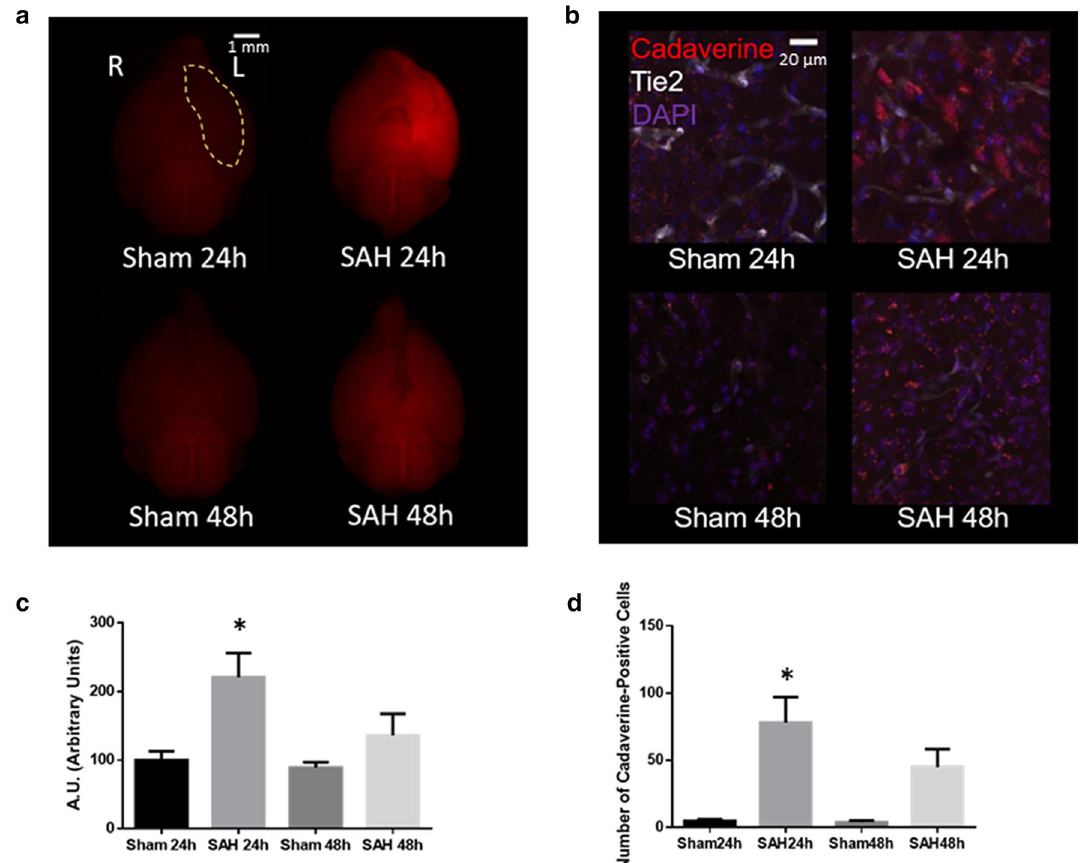
Figure 2. Blood–brain barrier (BBB) assessment after experimental SAH. ( a ) Whole brain fluorescent imaging from ventral perspective 24 h and 48 h after SAH or sham procedure. Left ventral region demarcated by yellow marking. Cadaverine dye fluorescence shown in red. ( b ) Confocal microscopy of coronal brain slices 24 h and 48 h after SAH or sham procedure. Cadaverine dye shown in red. Blood vessels shown in white with intrinsic Tie2-GFP fluorescence. Nuclei shown in blue with DAPI staining. ( c ) Quantification of cadaverine dye fluorescence from the left ventral region demarcated in ( a ). ( d ) Quantification of number of extravascular cadaverine-positive parenchymal cells. n = 3 per group. Data presented as means ± SEM. One-way ANOVA with Holm-Sidak post-hoc correction, * p < 0.05 (compared to Sham 24 h or Sham 48 h). Abbreviations: GFP = Green fluorescent protein. L = left. R =